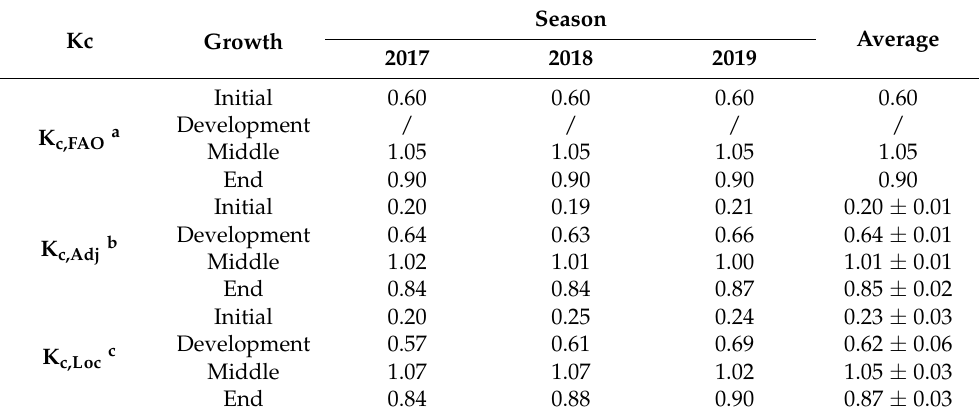
Table 2. Locally developed crop coefficient ( K c,Loc ) and adjusted crop coefficient ( K c,Adj ) for greenhouse-grown eggplant in the 2017–2019 growing seasons.